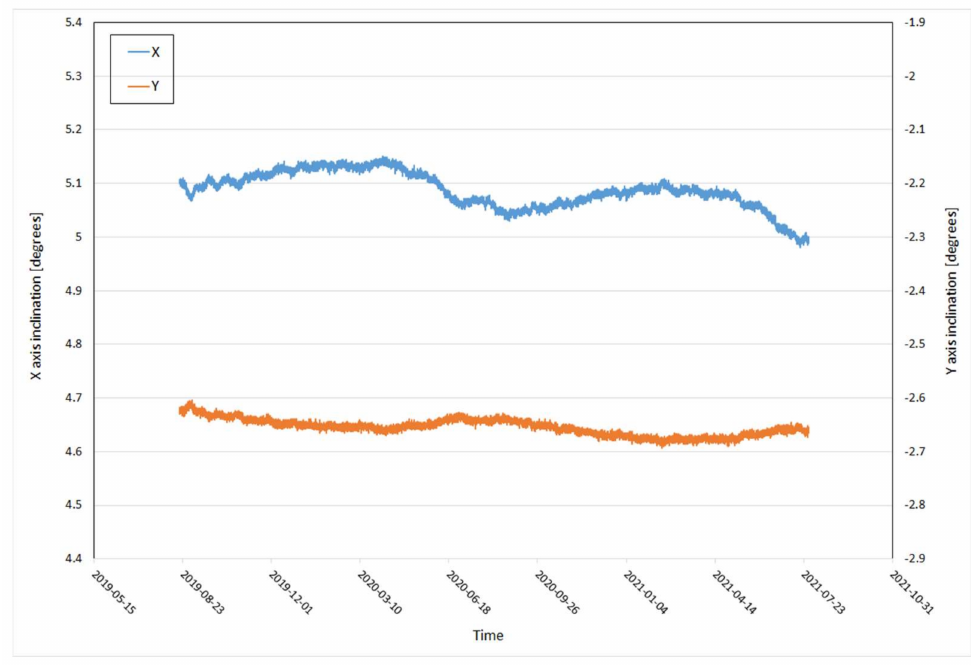
Figure 19. Changes in the slope (X and Y components) recorded on the second station with the sensor built into the roof of the excavation